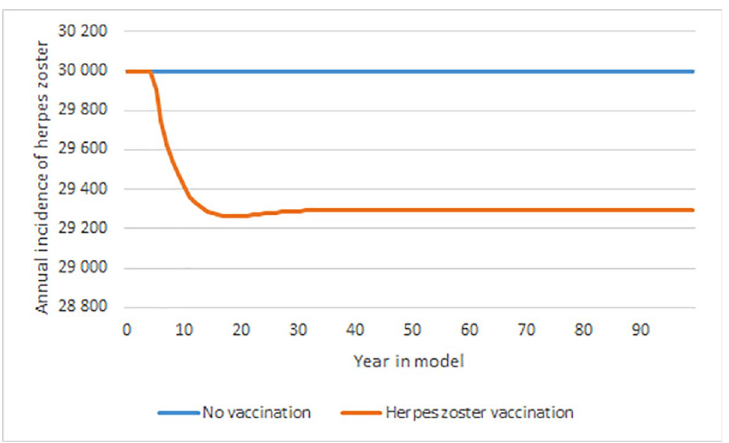
Fig 3. Annual number of herpes zoster cases with herpes zoster vaccination. All age groups, with and without herpes zoster vaccination, over a 100-year time horizon. Note the different values on the y-axis compared to Figs 2 and 4 herpes